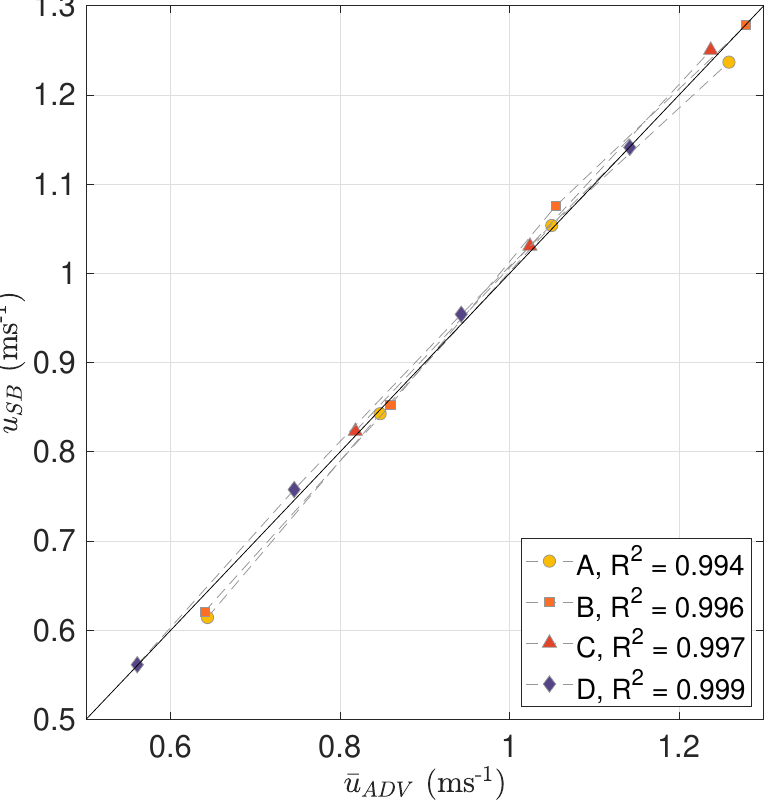
Figure 8. Direct inter-comparison of mean velocities measured by SB-ADP and ADV at the target locations A, B, C, and D, using the velocity of the measurement cells n 1 n 2 overlapping at the ADV measurement location. The straight line depicts a 1:1 relationship between the SB-ADP and ADV velocity measurement values.